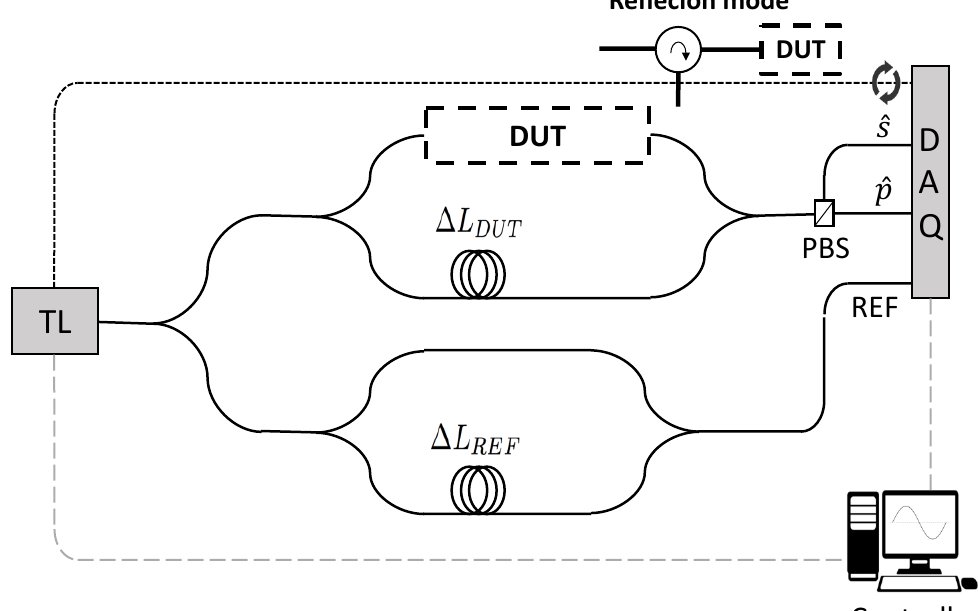
Figure 4. Optical frequency domain reflectometry setup. Abbreviations: Device under test (DUT), Reference (REF), polarization beam splitter